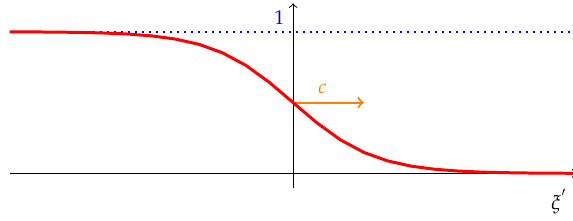
Figure 1. Profile of the traveling wave resulting from Proposition 2. This figure shows the traveling wave front connecting the two equilibria, the one where the population is composed only by cooperators ( q = 1) and the one where there are just defectors ( q = 0). Under the hypothesis of Proposition 2, the traveling front moves from the left to the right with constant positive speed, c , showing the diffusion of cooperators. See [30] for more detailed explanations about traveling wave